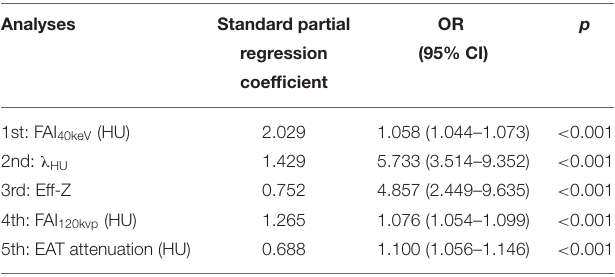
TABLE 4 | The association of PCAT measures and EAT attenuation with the presence of CAD. Analyses